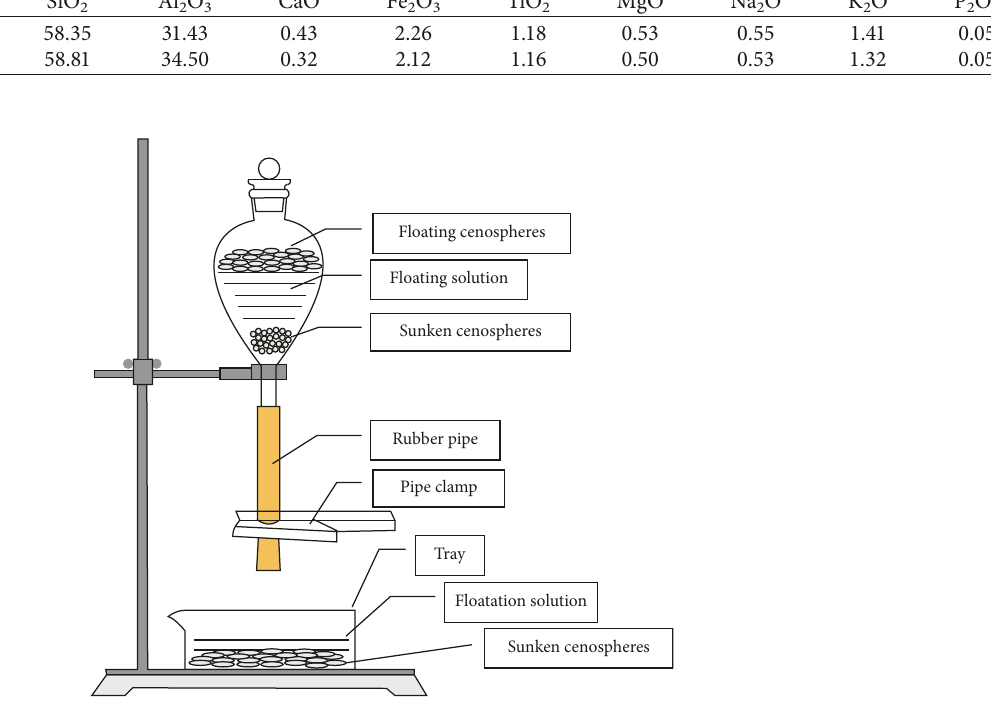
Figure 1: Schematic drawing of flotation device. Table 4: Mix proportions of foam